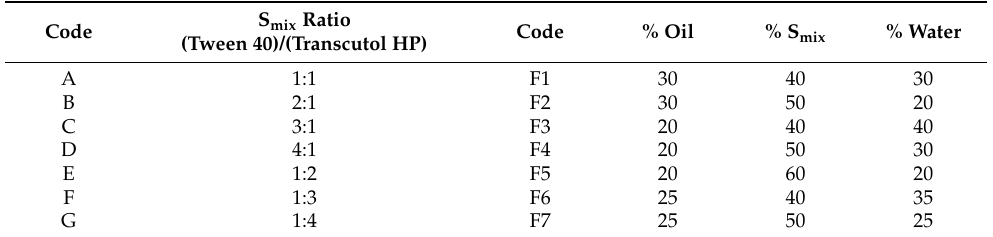
Table 1. Various ratios were used for the preparation of the initial 49 formulations of TAM in a nanoemulsion (NE) based system. The oils used were olive and sesame.